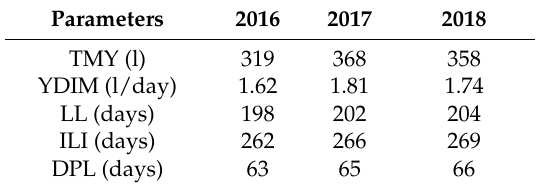
Table 1. Productive parameters of the farm during the period studied